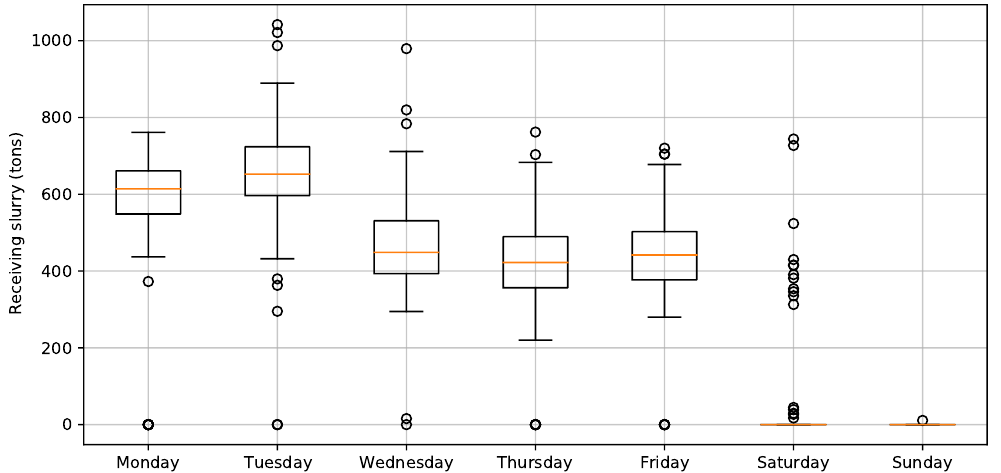
Figure 2. Weekly receiving schedule for slurry for data from 1 January 2016, to 27 January 2019. The boxes span from the 25% to the 75% quartiles and the respective median is given as orange line, while the whiskers extent to maximum 1.5 times the interquartile range. The remaining points are given as